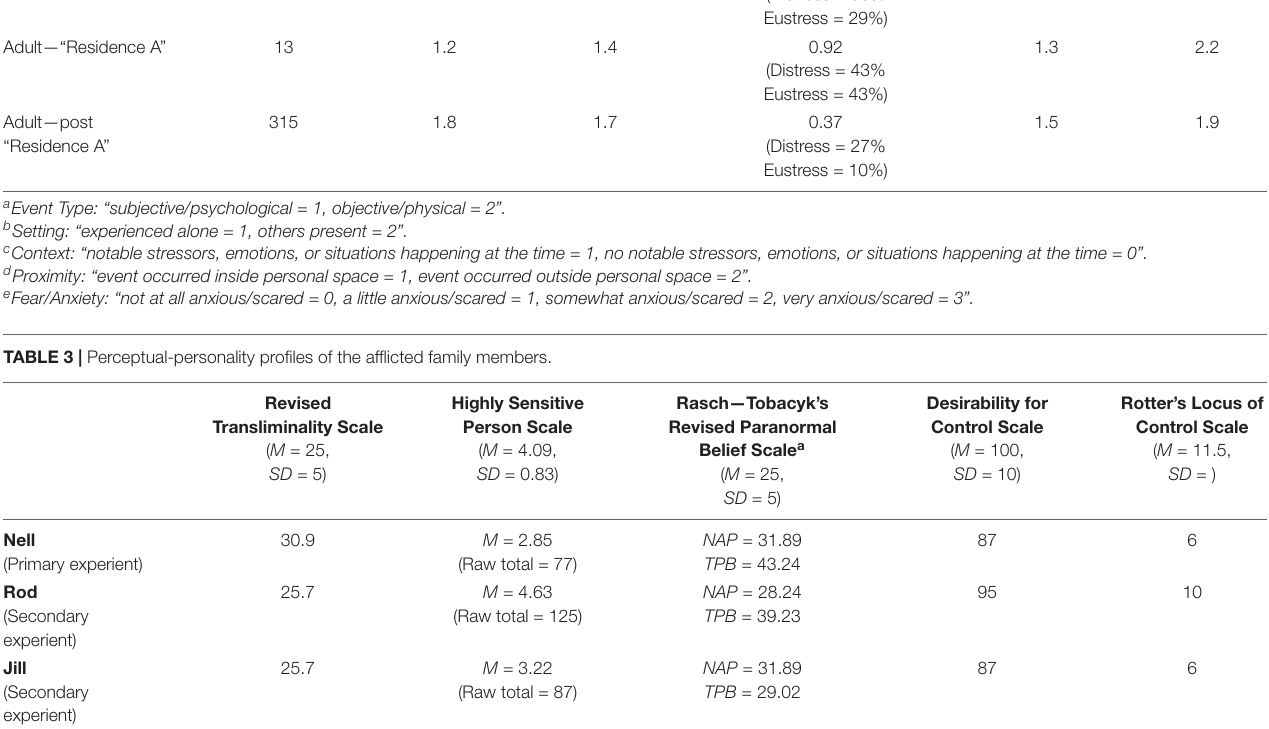
TABLE 2 | Mean characteristics of the primary percipient’s history of encounter experiences. Number of Event type a Setting b Context c (% of experiences memorable events